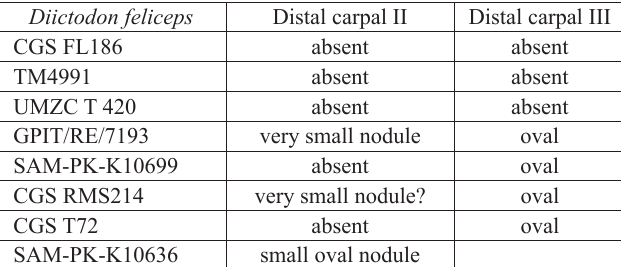
Table 2. State and shape of distal carpals II and III in different Diicto­ don specimens. The specimens are ordered (top to bottom) according to the increasing length of their skulls and/or their long